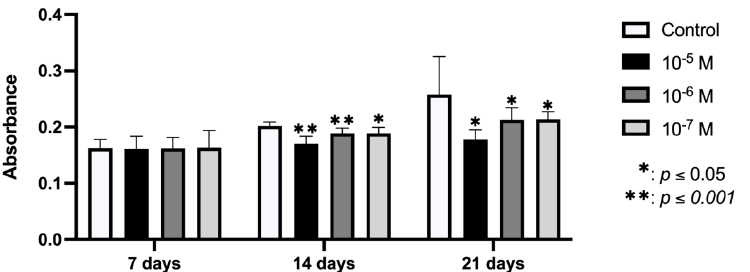
Figure 4. Quantitative study of mineralization of primary cell lines through nodule formation, after culture in osteogenic medium supplemented with BPA (10 −5 , 10 −6 , or 10 −7 M). Data are reported as means of absorbance ± standard deviation. Significant differences * p < 0.05; ** p < 0.001.